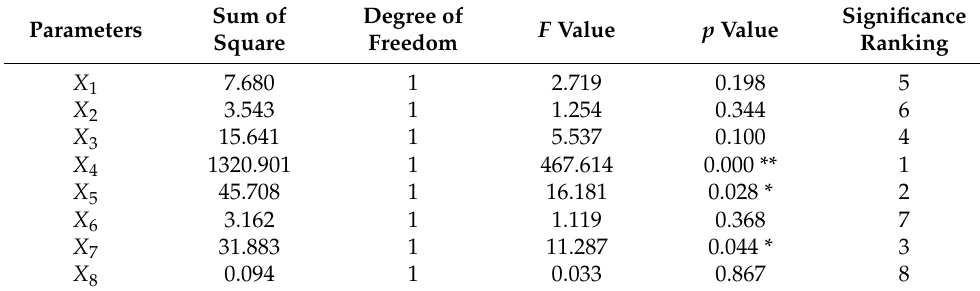
Table 6. Significance analysis of the Plackett-Burman test parameters.